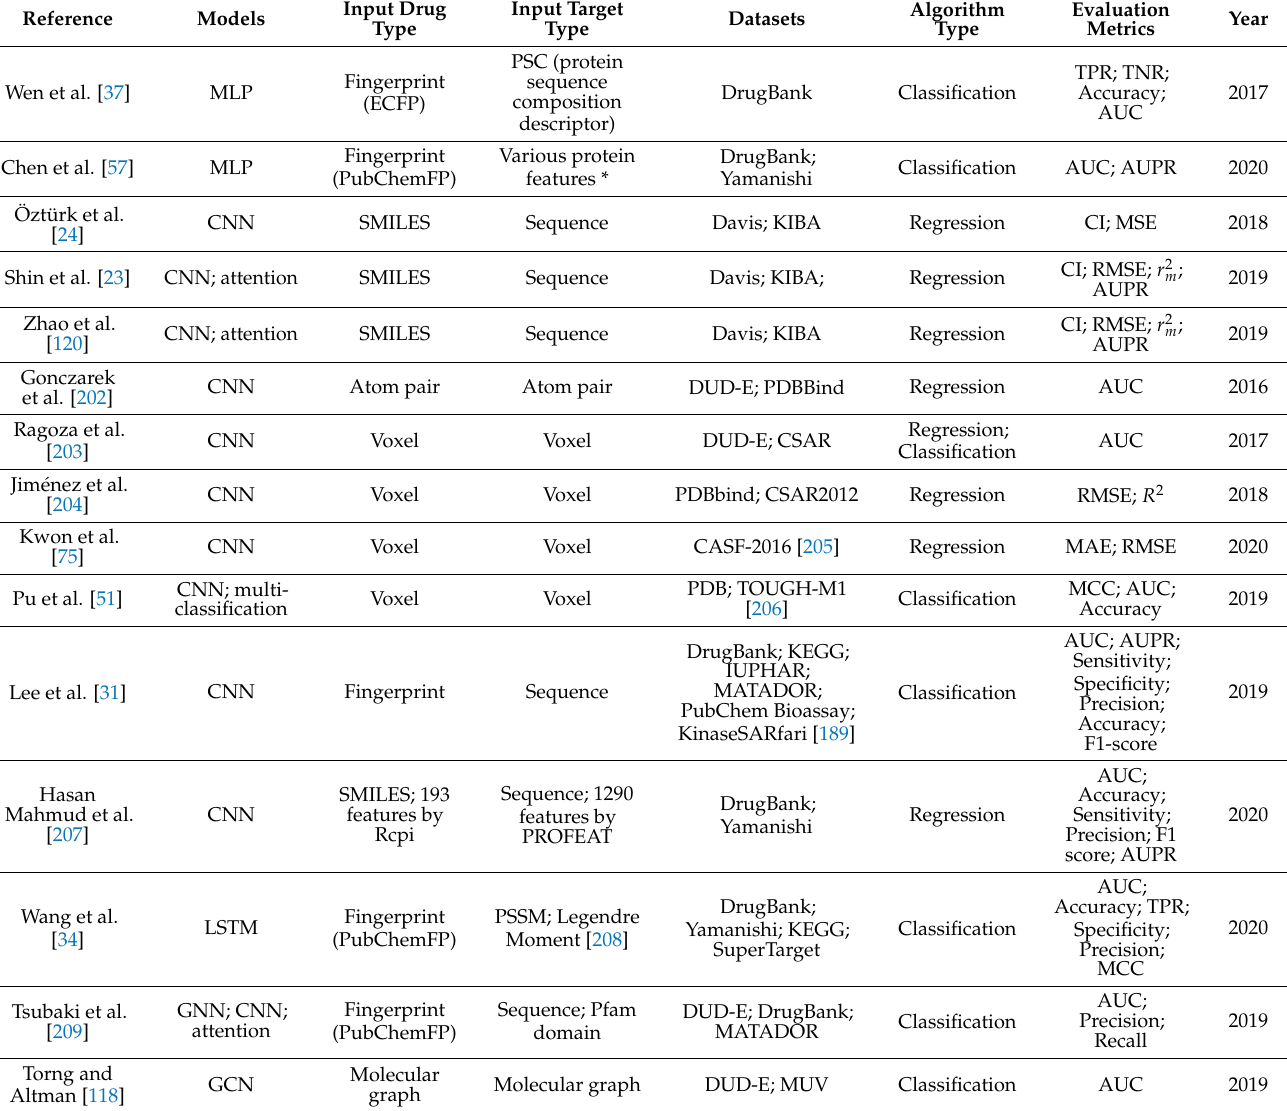
Table A2. Structure-based DL methods for DTI